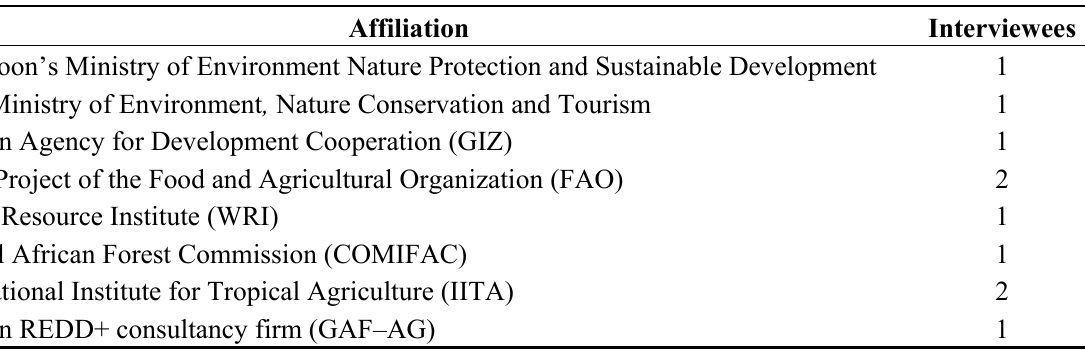
Table 3. Affiliations of the